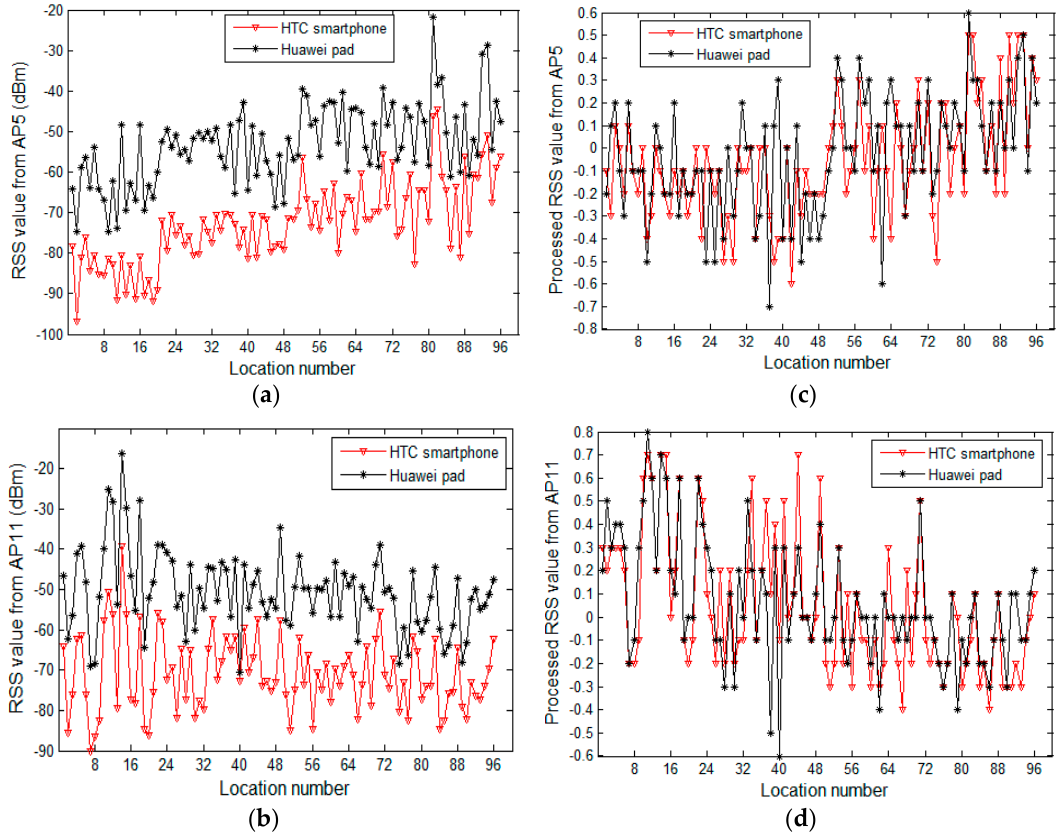
Figure 4. RSS values change versus observation locations: ( a ) the change in raw RSS values of AP5 versus observation locations; ( b ) the change in raw RSS values of AP11 versus observation locations; ( c ) the processing result of ( a ); and ( d ) the processing result of ( b ).